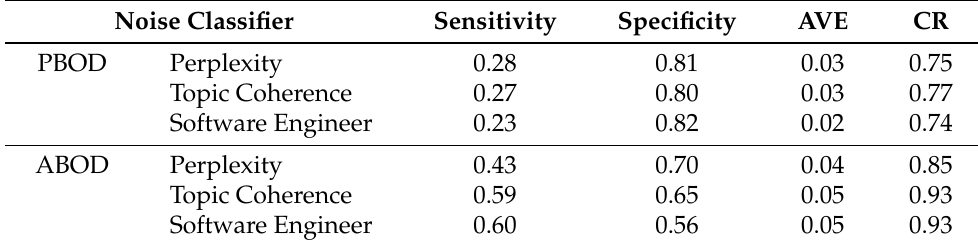
Table 4. Sensitivity and Specificity Values on the DA-07 SRS